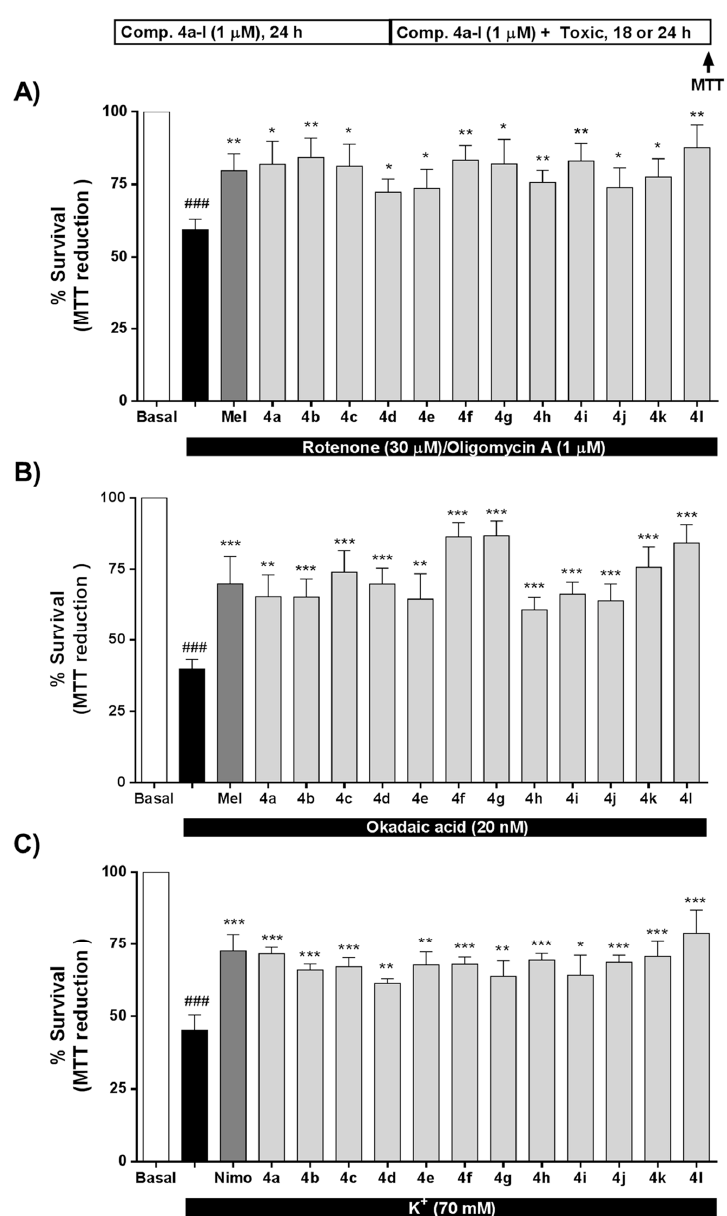
Figure 3. Neuroprotective activity of compounds 4a – l against the toxicity exerted by ( A ) oxidative stress, ( B ) tau hyperphosphorylation and ( C ) [Ca 2 + ] c overload. SH-SY5Y neuroblastoma cells were treated with compounds 4a-l (1 µ M) or reference compounds (melatonin or nimodipine, 1 µ M) during 24 h. Thereafter, cells were co-incubated with compounds 4a-l, melatonin or nimodipine (1 µ M) and the corresponding toxic stimuli, R / O combination (30 / 10 µ M, oxidative stress, 24 h), okadaic acid (OA) (20 nM, tau hyperphosphorylation, 18 h) or 70 mM K + ([Ca 2 + ] c overload, 24 h). Cell viability was assessed by the 3-(4,5-dimethylthiazol-2-yl)-2,5-diphenyltetrazolium bromide (MTT) reduction assay. Values are expressed as mean ± S.E.M of five independent experiments in triplicate and results were normalized to basal conditions (100%). ### p < 0.001 compared to basal condition; * p < 0.05, ** p < 0.01, *** p < 0.001 compared to toxic stimuli treated